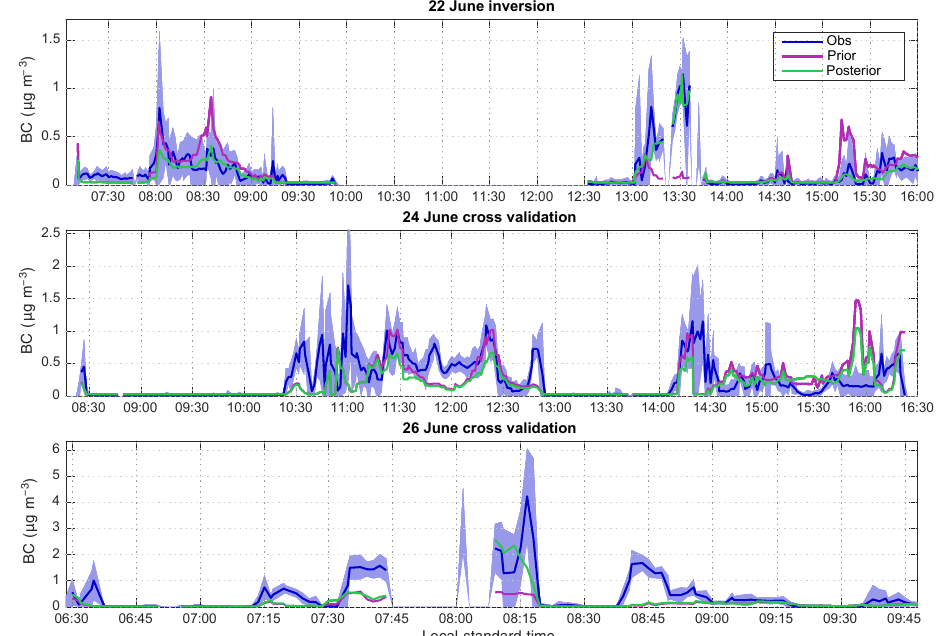
Figure 4. Temporal variation of observed, prior, and posterior BC concentrations during ARCTAS-CARB. The model values are obtained with the FINN_STD inversion scenario. The shaded area encompasses 2 standard deviations around the observations, which includes both model and observation